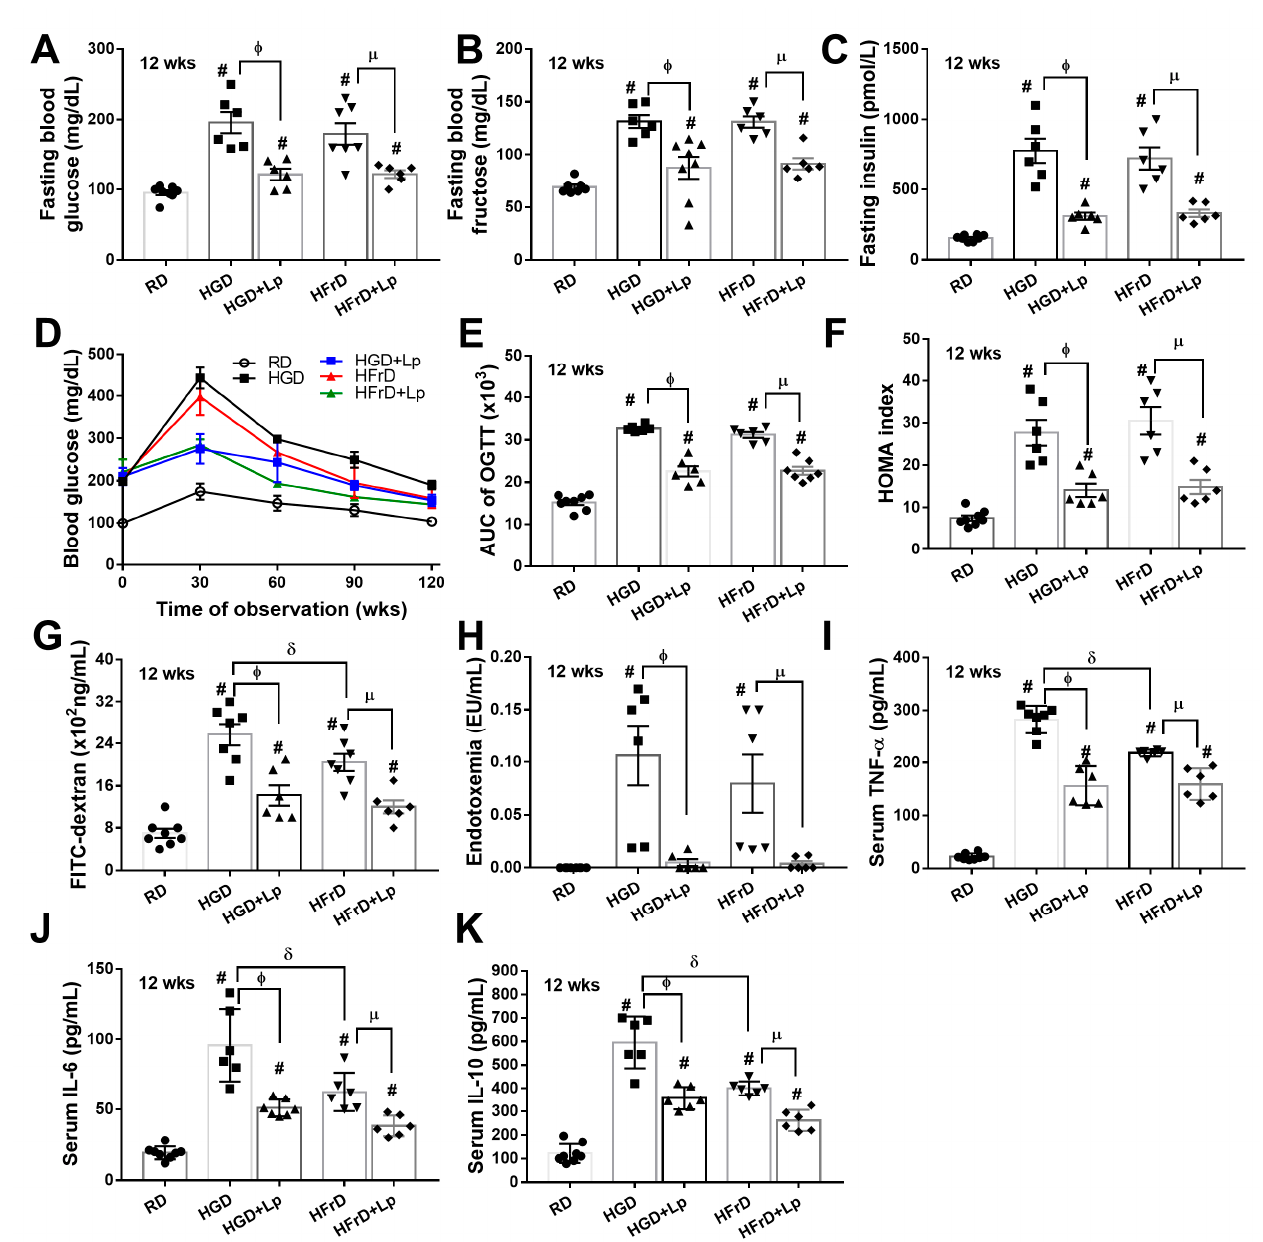
Figure 2. Characteristics of mice with regular diet (RD), or high-glucose diet (HGD), or high-fructose diet (HFrD) with or without Lactiplantibacillus plantarum (Lp) are demonstrated as determined by fasting blood profile (glucose, fructose, and insulin) ( A – C ), oral glucose tolerance test (OGTT) with the area under the curve (AUC) of the graph ( D , E ), homeostatic model evaluation of insulin resistance (HOMA index) ( F ), intestinal leakage (FITC-dextran) ( G ), serum endotoxin ( H ) and serum cytokines (TNF- α , IL-6 and IL-10) ( I – K ) (n = 6–8/group or time-point). #, p < 0.05 vs. RD; φ , p < 0.05 HGD vs. HGD+Lp; µ , p < 0.05 HFrD vs. HFrD+Lp; δ , p < 0.05 HGD vs. HFrD.